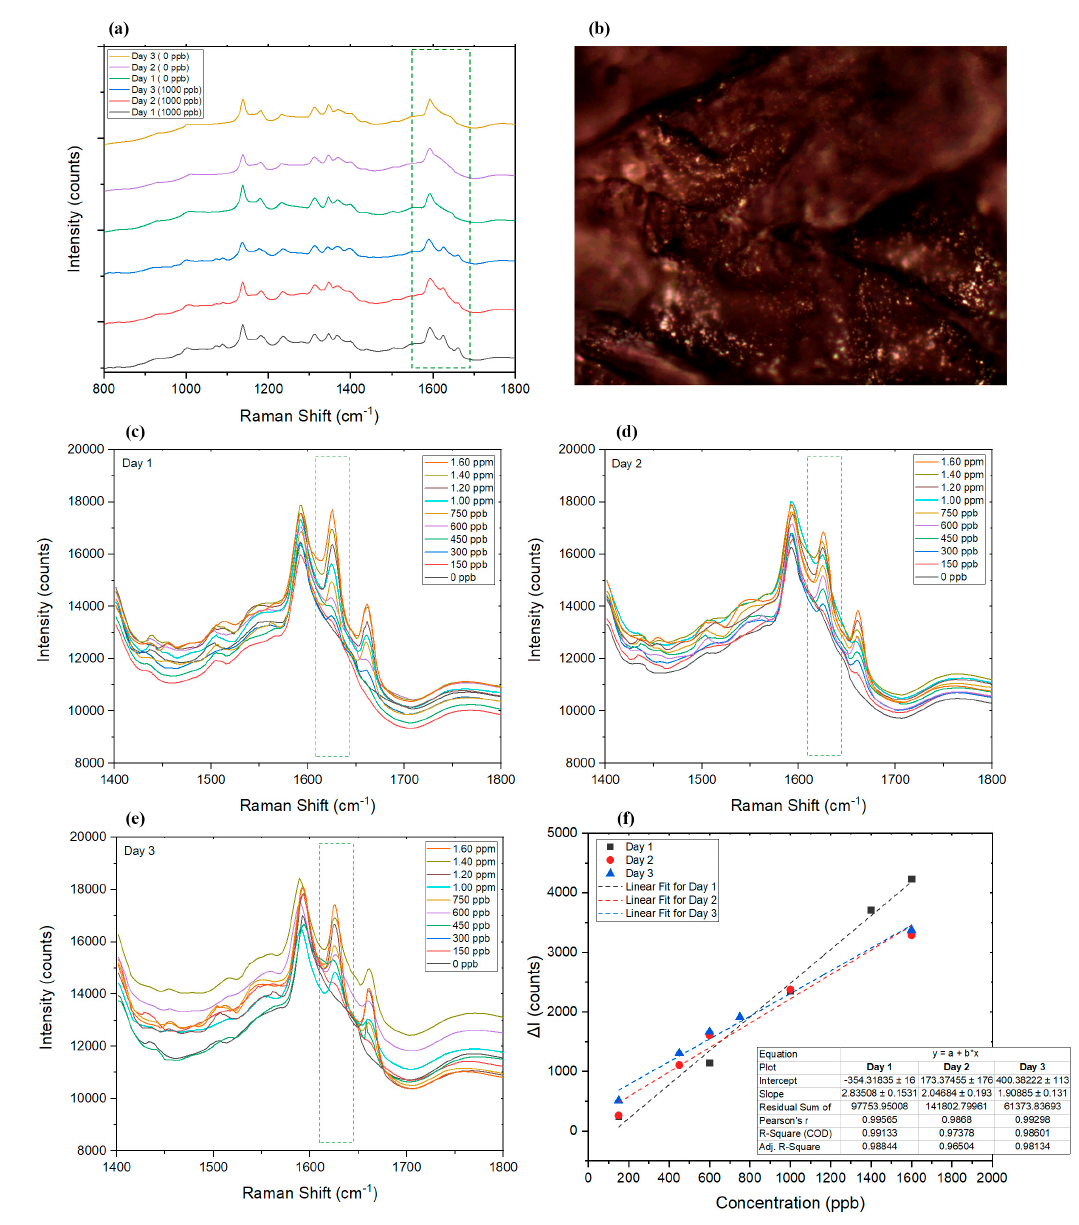
Figure 6. ( a ) SERS results of the dried blood sample with (1000 ppb) and without (0 ppb) AMT on days 1, 2, and 3. ( b ) Dried blood sample under the Raman microscope (50× objective). ( c – e ) Graphs representing the Raman spectra of samples on days 1, 2, and 3, respectively. ( f ) Comparison of the linear range of the utilized SERS technique on days 1, 2, and 3. Δ I represents the changes in intensity at the selected wavelength in the presence of AMT compared to the Raman intensity at the peak wavelength of blank sample (dried blood without AMT).